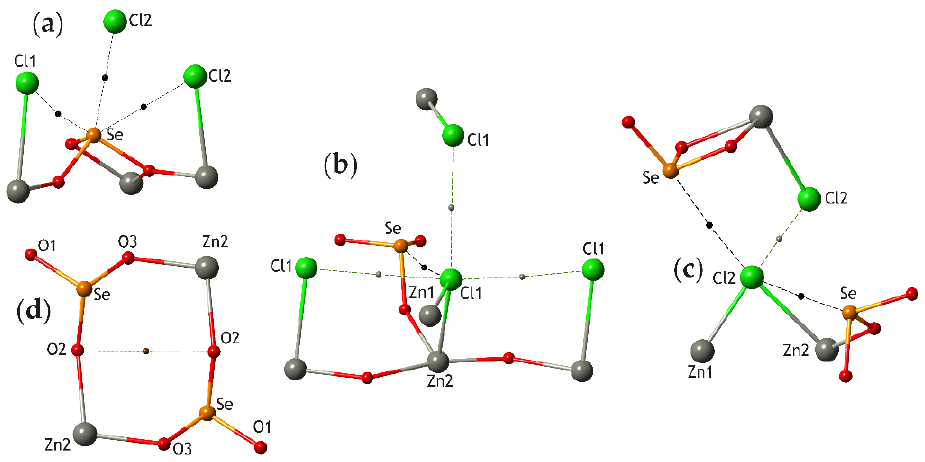
3 Cl 3 ) prism with the O 3 and Cl 3 triangular bases. The Se–O interactions are